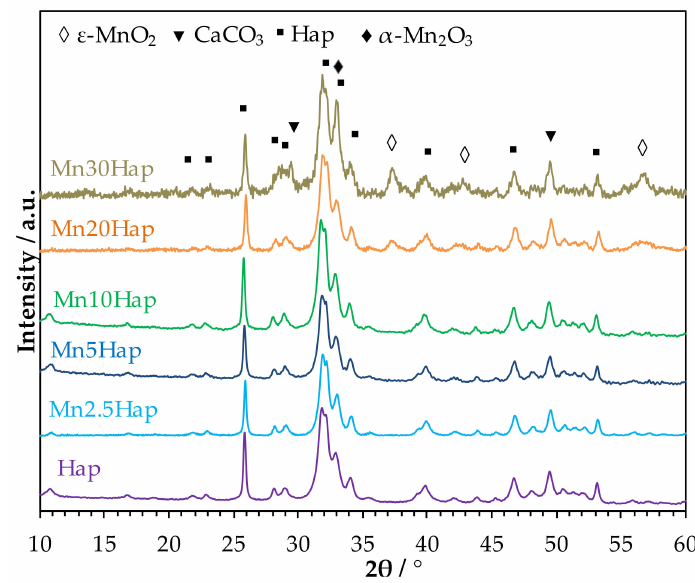
Figure 1. X-ray di ff raction pattern of pure Hap and MnxHap